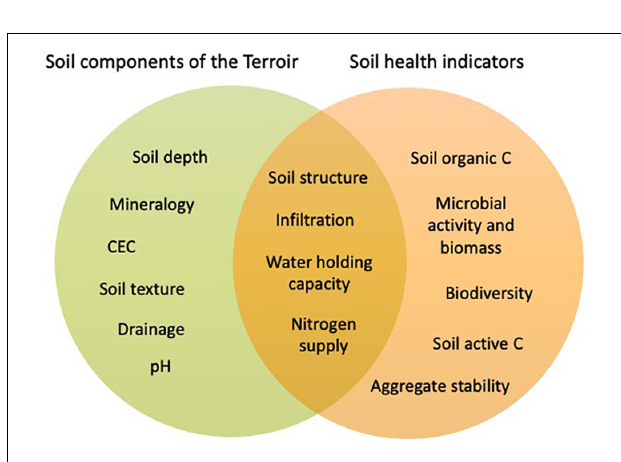
FIGURE 1 | Definition of soil health with representation of soil functions performed by a healthy soil.